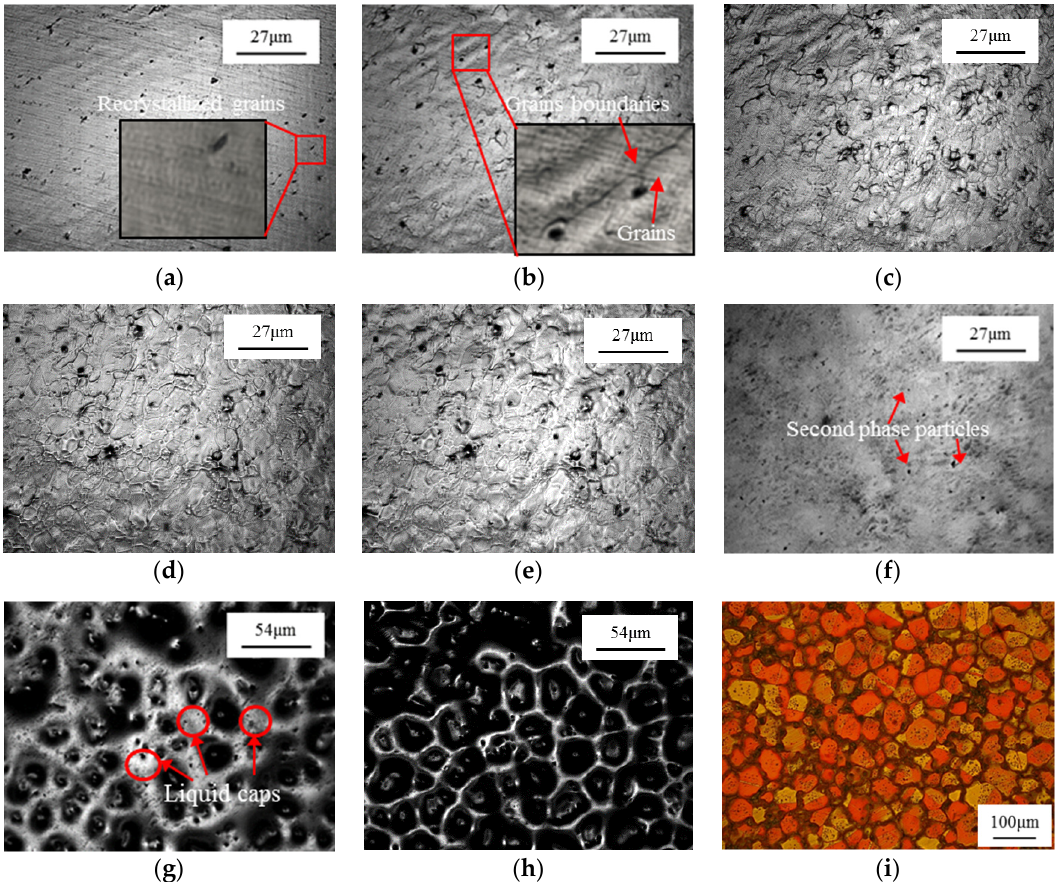
Figure 2. HT-CLSM-assisted in situ microstructural observations of rotary swaged C5191 alloy with rotary swaged strain of 0.3 during thermal cycle (Figure 1b) at different temperatures: ( a ) 606 °C , ( b ) 745.9 °C, ( c ) 852.0 °C, ( d ) 896.9 °C, ( e ) 897.8 °C, ( f ) 940 °C, ( g ) 902.5 °C, and ( h ) 892.2 °C; ( i ) optical image of solidified microstructure.